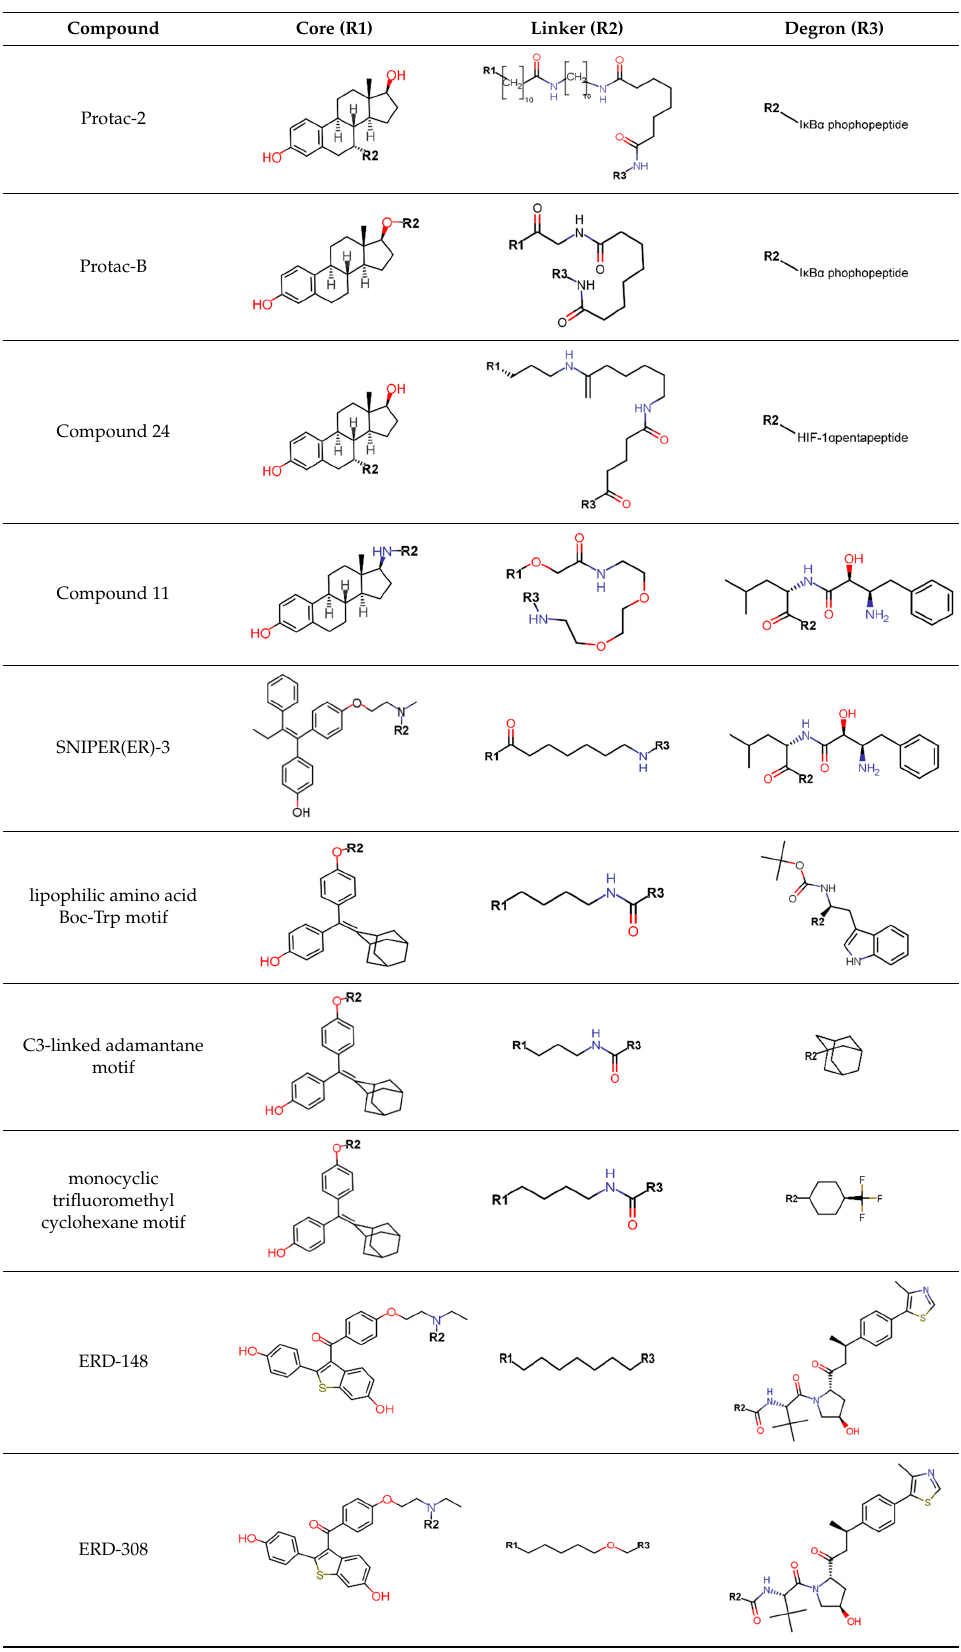
Table 4. PROTAC ligands for ER.